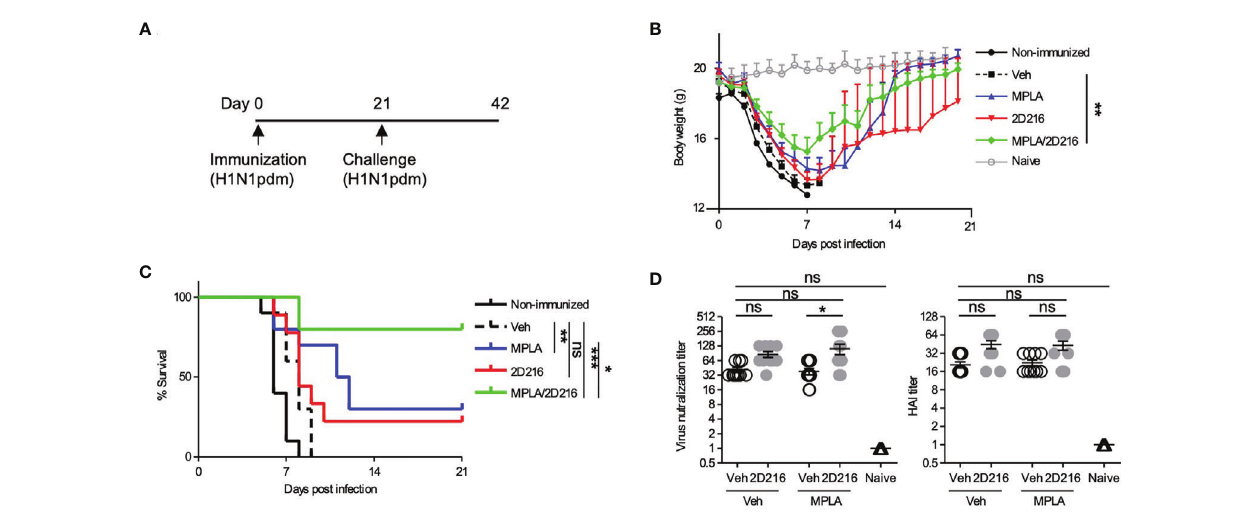
FIGURE 6 | MPLA/ 2D216 adjuvanted IIAV vaccination protects mice from lethal in fl uenza virus challenge. (A) BALB/c mice (n = 10/group) were immunized with IIAV adjuvanted with vehicle (Veh; 10%DMSO in saline), MPLA (1 m g/mouse), 2D216 (100 nmol/mouse), or MPLA/ 2D216 on day 0 and were infected with homologous in fl uenza virus (H1N1)pdm09 on day 21. Body weights and survival were monitored for 21 days. (B) Body weights are indicated as mean ± SEM. For statistical analysis, last- value-carried-forward approach was used to impute missing values after a mouse died. The average weight over time was used as an outcome for comparison. *p < 0.05, **p < 0.01, ***p < 0.001 by Kruskal-Wallis tests with Dunn ’ s post hoc test. (C) Survival rates of mice post-challenge with homologous in fl uenza virus. Kaplan-Meier curves with the log- rank test are shown. *p < 0.1, **p < 0.01, ***p < 0.0001, and ns, not signi fi cant. (D) The sera were collected from the mice prior to lethal challenge and tested for titer against the HA protein and viral neutralization. Data shown are means ± SEM. *p < 0.05, **p < 0.01, ***p < 0.001 by Kruskal-Wallis tests with Dunn ’ s post hoc